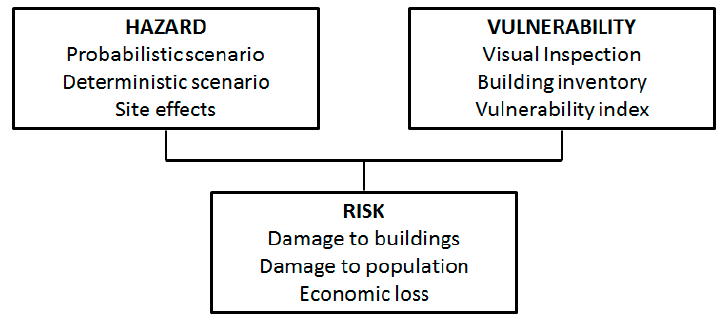
Figure 1. Flow chart of the adopted methodology for the seismic risk assessment in